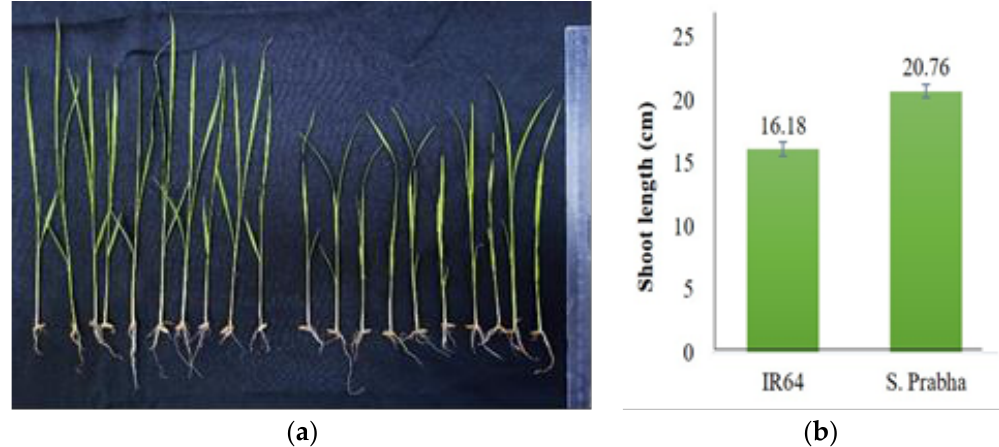
Figure 3. Morphologies ofIR-64 and Swarnaprabha 21-day-old seedlings grown in light-controlled growth chambers.